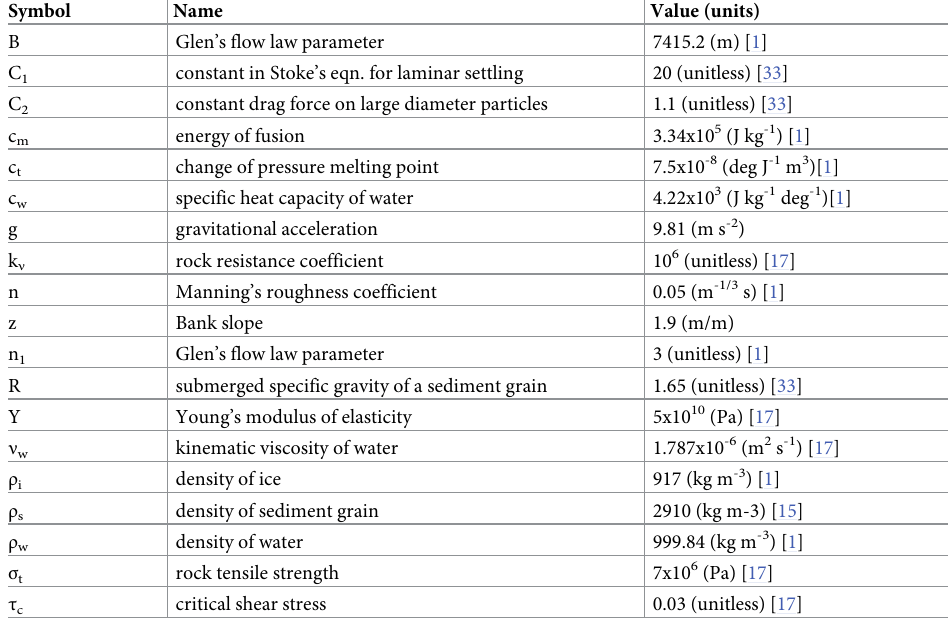
Table 1. Constants.